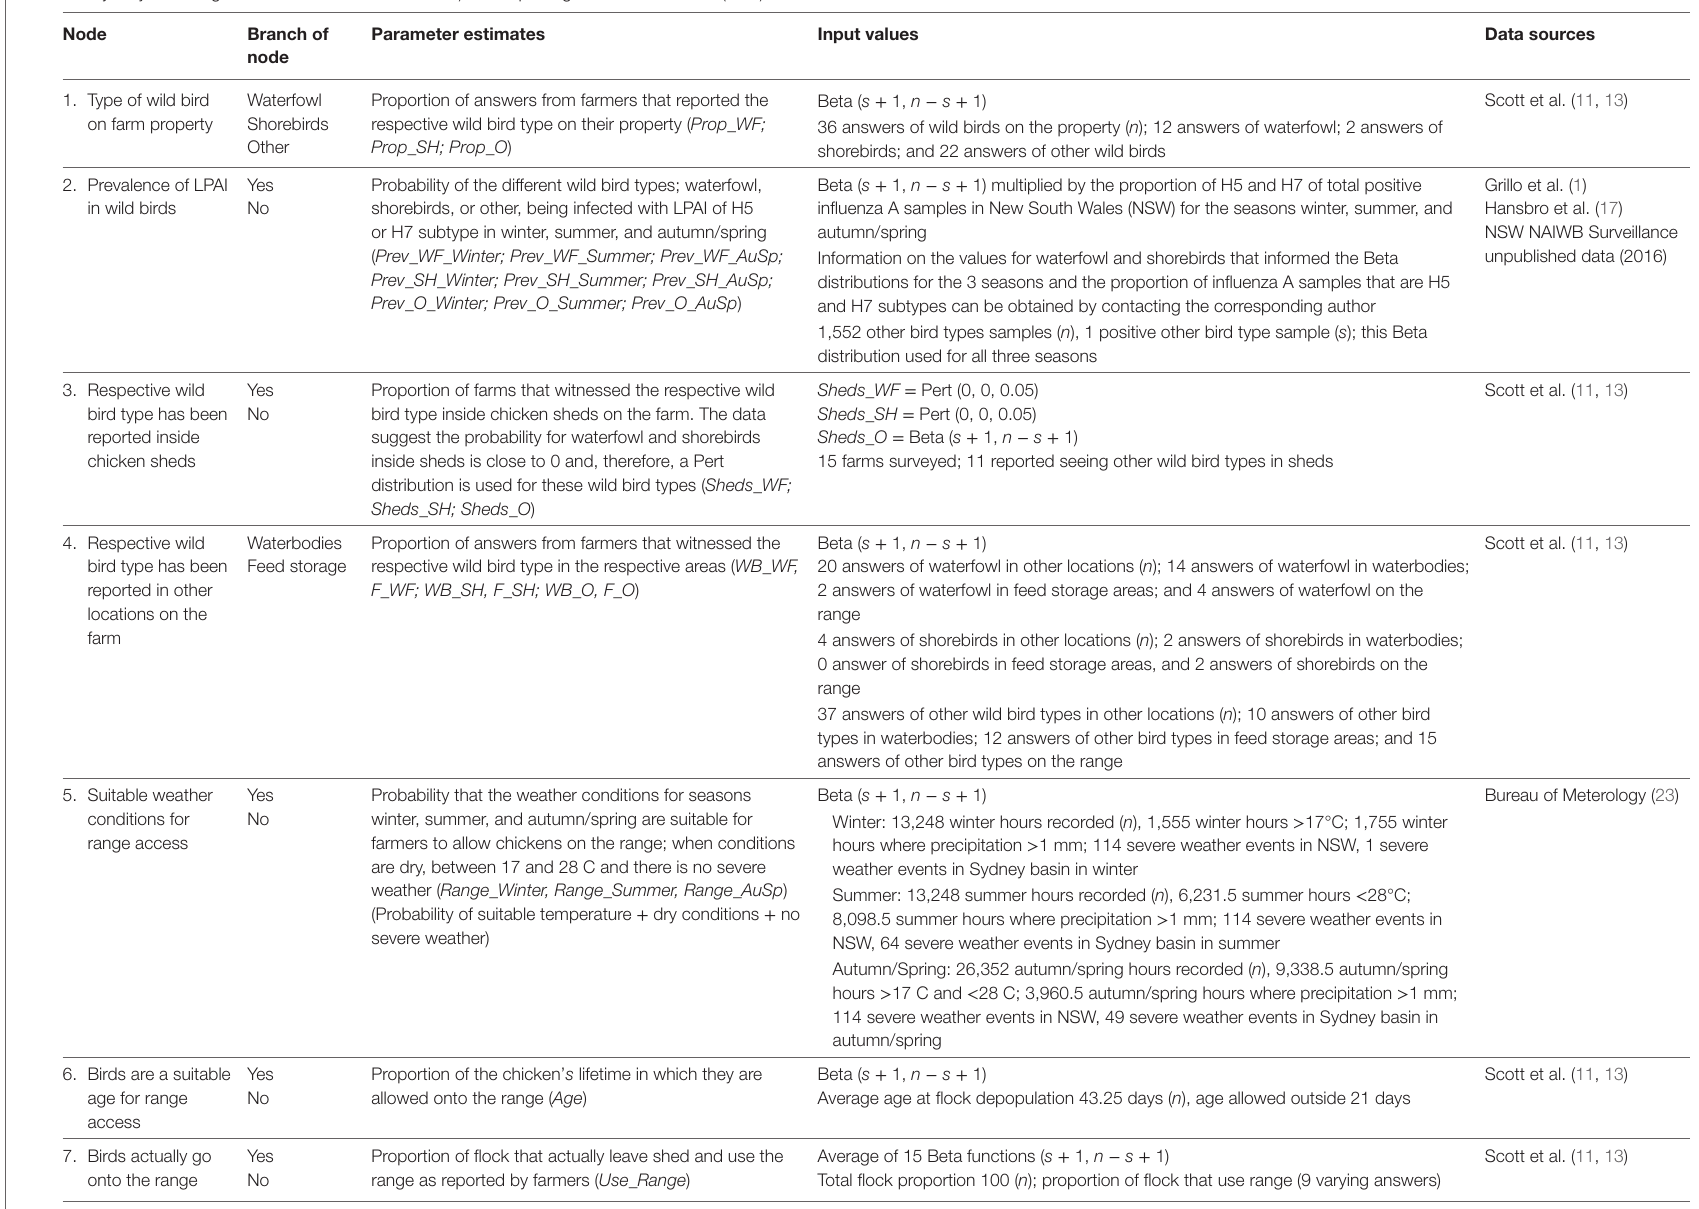
TaBle 2 | Nodes, parameter estimates, and input values used for the exposure assessment estimating the probability of exposure of commercial chickens on free-range meat chicken farms in Australia (specifically in the Sydney basin region and South East Queensland) to low pathogenic avian influenza (LPAI) from wild